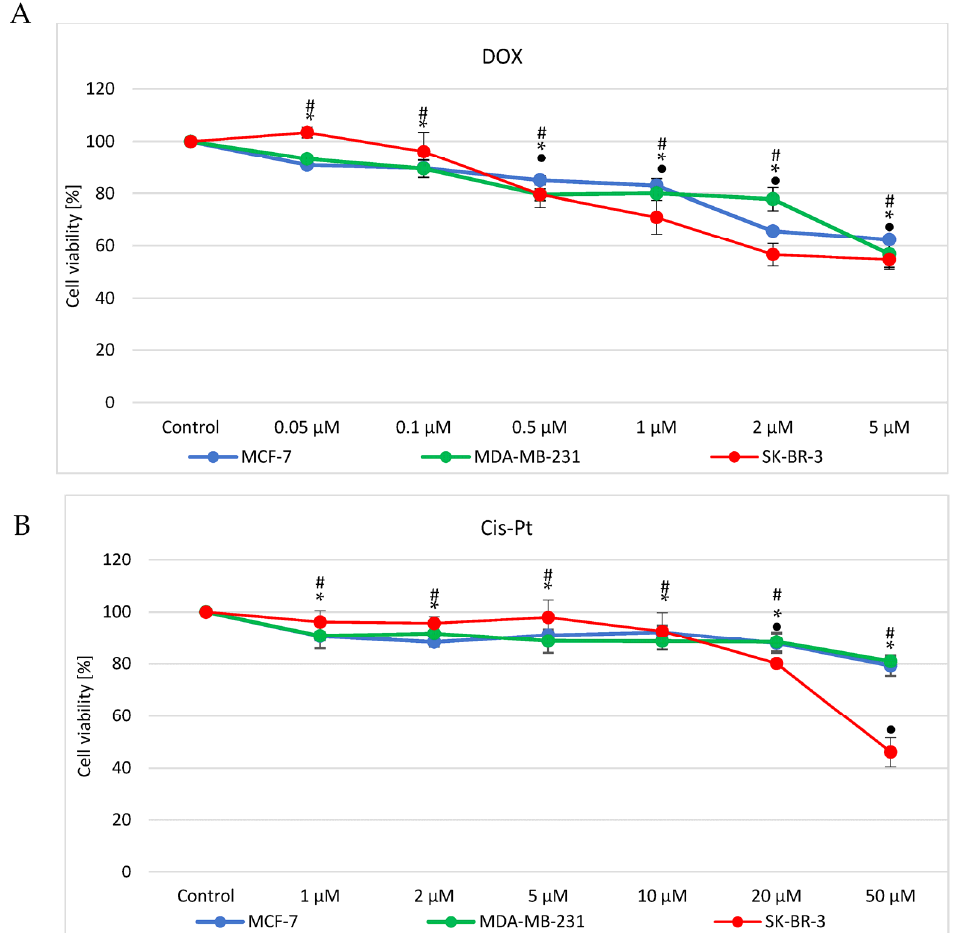
Figure 1. Cytotoxicity assessment and determination of the optimal range of drugs concentration i.e., doxorubicin ( A ) and cisplatin ( B ). MTT assay was performed to find optimal concentrations of doxorubicin and cisplatin for evaluation of miRNAs alterations as a response. Cells were treated for